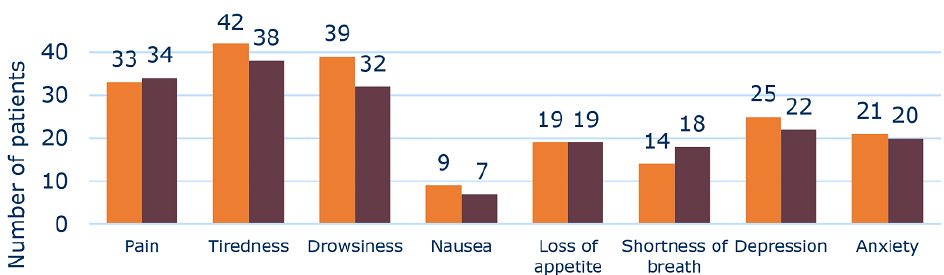
Figure 4. Number of Deprescribing Subgroup patients ( n = 48) with any presentation of each symptom (answers higher than 0 on the Edmonton Symptom Assessment System (revised version) scale) before (orange) and after (brown) deprescribing. There was no significant difference for any symptoms.